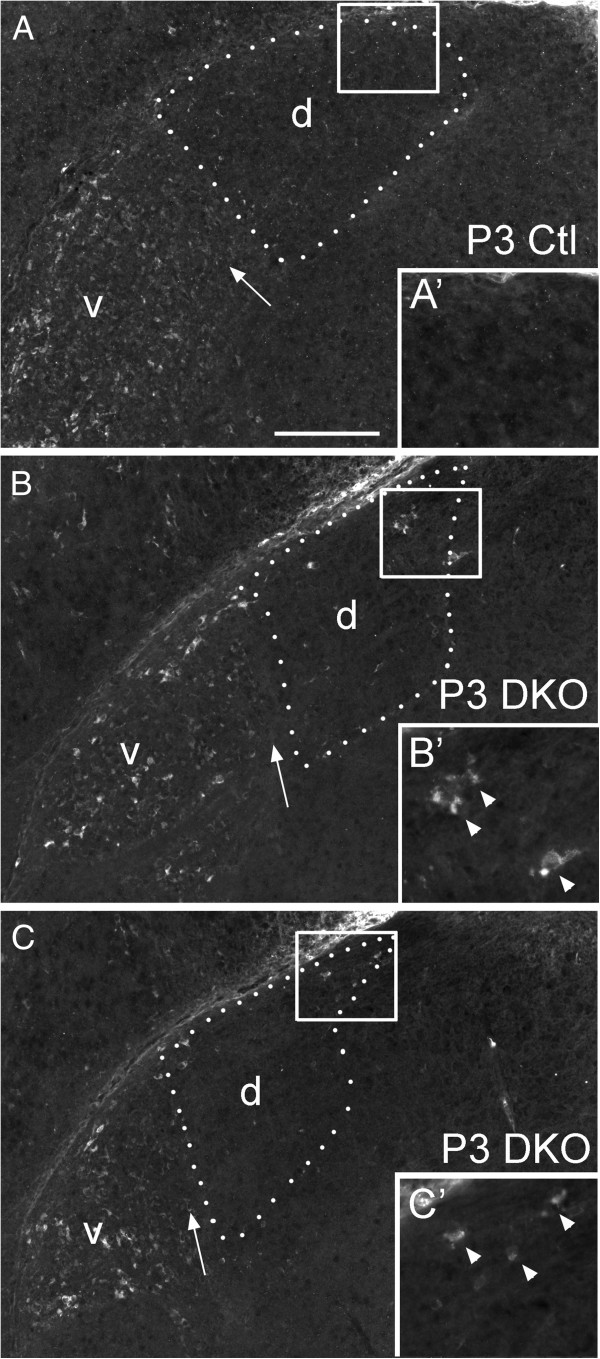
Ectopic distribution of reelin in vldlr−/−;lrp8−/− mutant LGN. Reelin distribution was assessed by immunostaining (A) P3 control and (B,C)vldlr−/−;lrp8−/− mutant (DKO) LGN. Insets show high magnification images of the areas indicated by boxes. Note in (B,C), the presence of reelin-immunoreactivity in the dorsomedial pole of DKO mutant dLGN. For all images, the outline of the dLGN is depicted with white dots. dLGN are labeled ‘d’, vLGN are labeled ‘v’ and arrows indicate IGL. Scale bar = 180 μm for (A to F) and 50 μm for insets. DKO, double knockout; dLGN, dorsal LGN; IGL, intergeniculate leaflet; LGN, lateral geniculate nucleus; vLGN, ventral LGN.